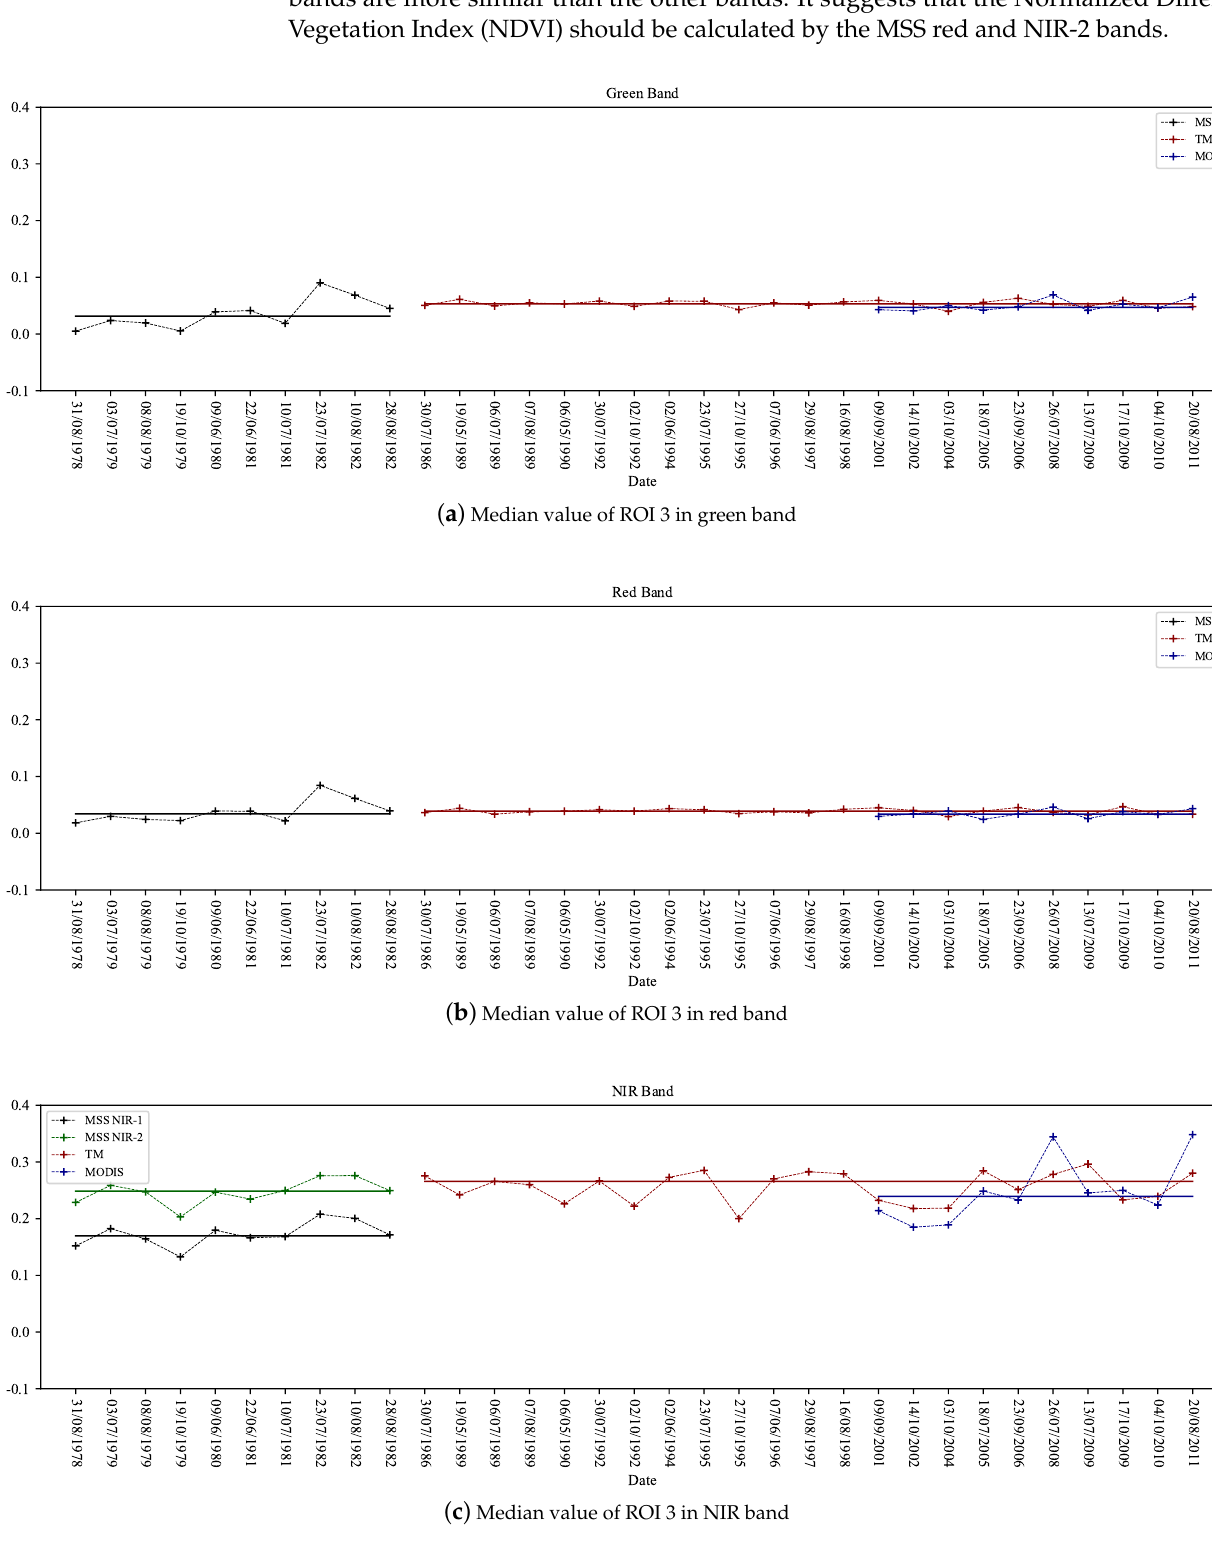
Figure 14. Time series of ROI 3 median value (ROI 3: